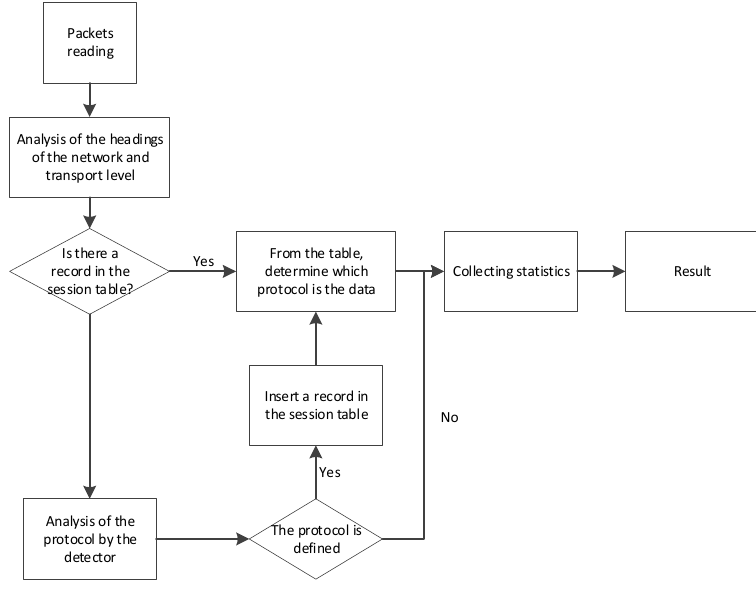
Figure 7. Algorithm of software system for network traffic capturing, analyzing, and detecting.